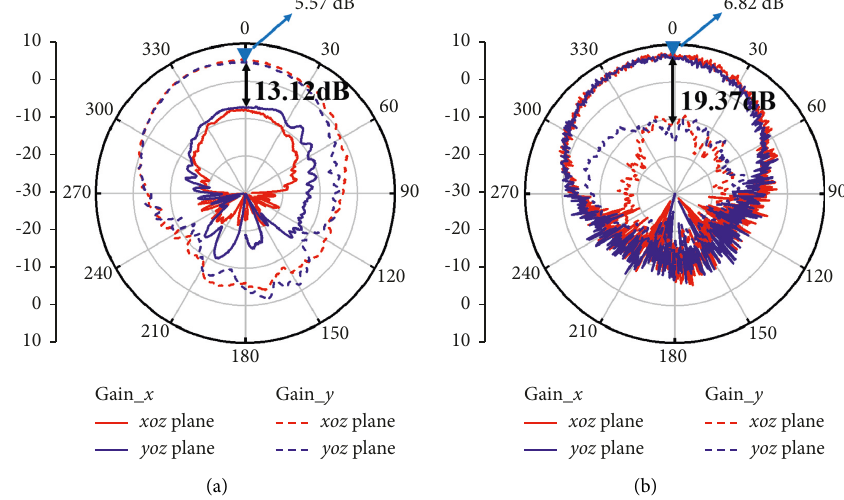
Figure 8: Measured radiation performance of the proposed antenna. (a) Radiation pattern on xoz and yoz plane at 10.6 GHz. (b) Radiation pattern on xoz and yoz plane at Table 1: Comparison with other dual-polarized dual-band antennas. Ref.